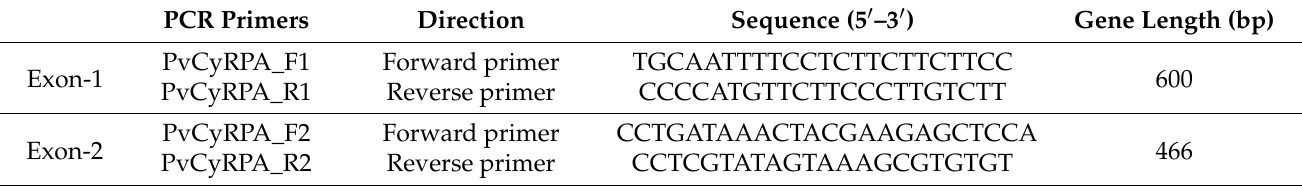
Table 1. Polymerase chain reaction (PCR) primers used for the amplification of the pvcyrpa gene. PCR